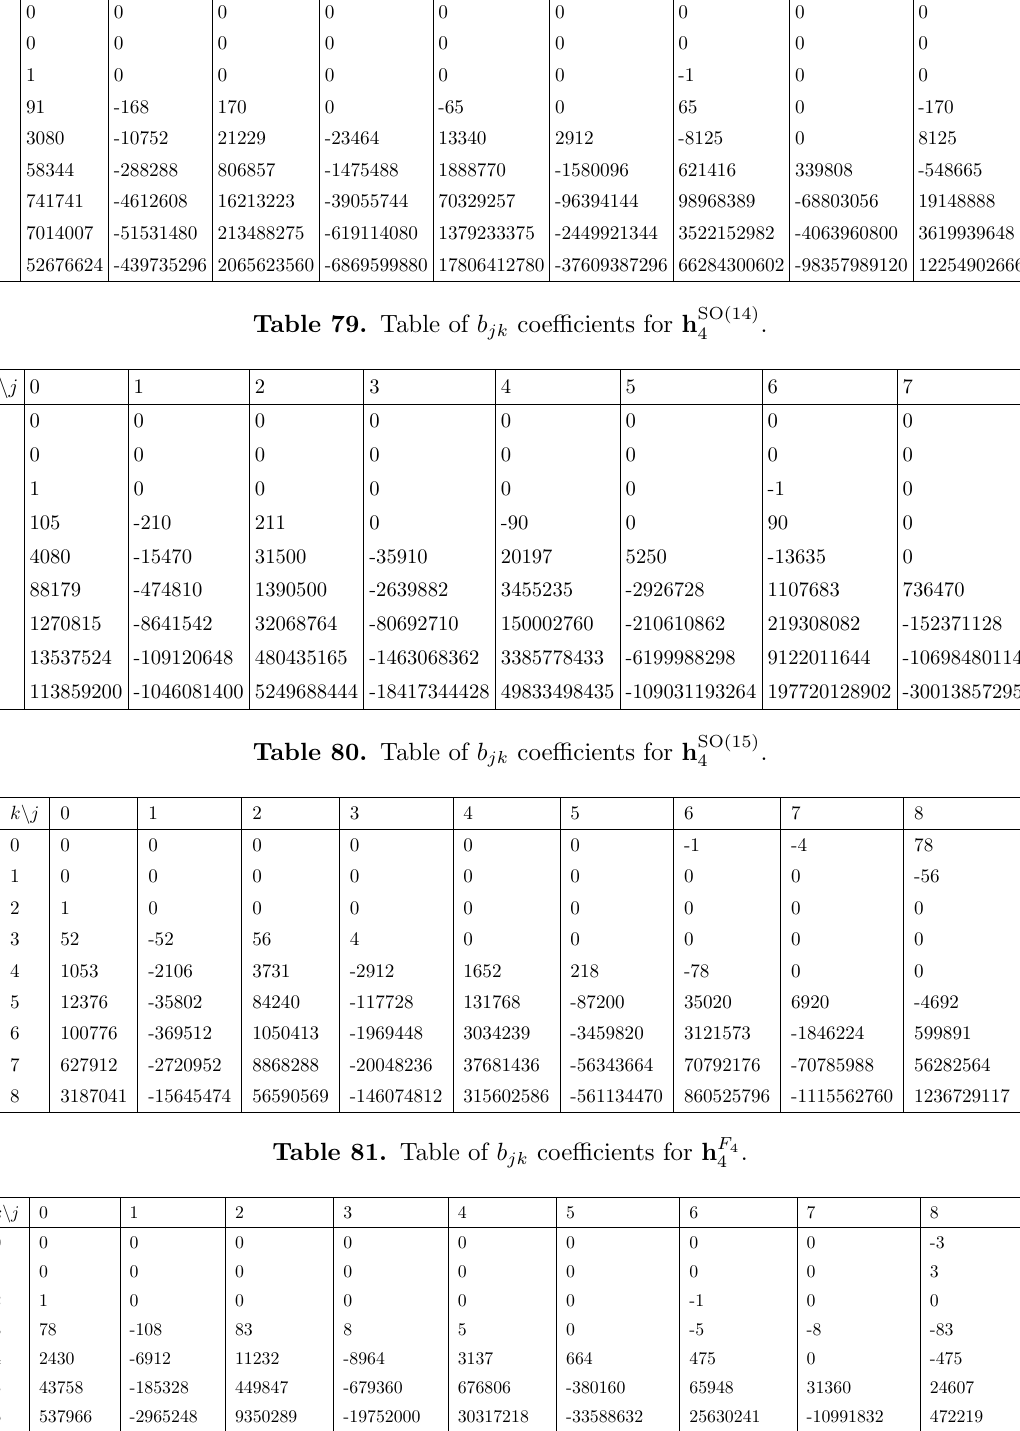
Table 82. Table of b jk coe(cid:14)cients for h E 6